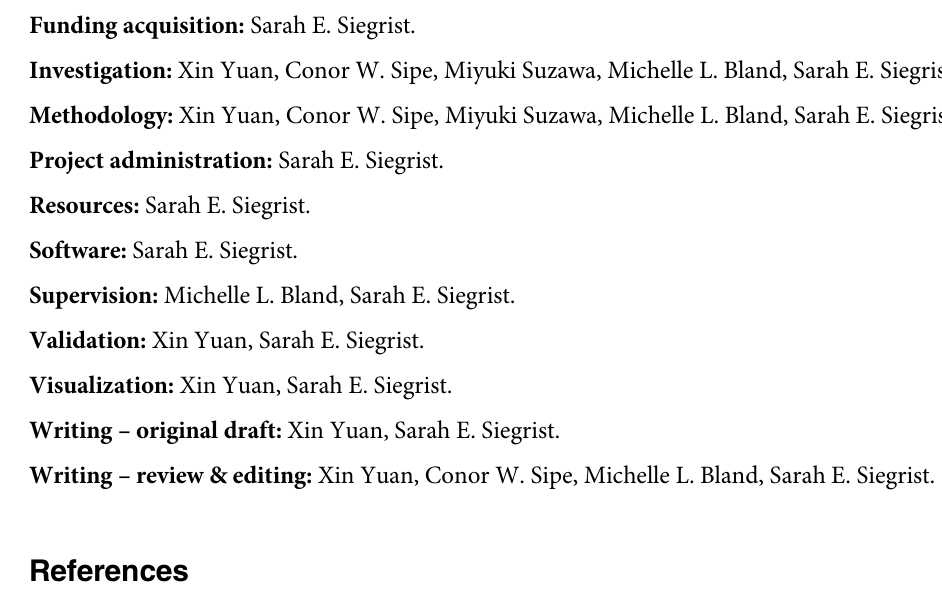
S1 Table. Classification of glial GAL4 expression in the larval brain after 24 hours of feed- ing. S2 Table. Genotypes listed by figure panel. S3 Table. Drosophila stock list and source. S1 Data. Excel spreadsheet with data listed for all main and supplementary